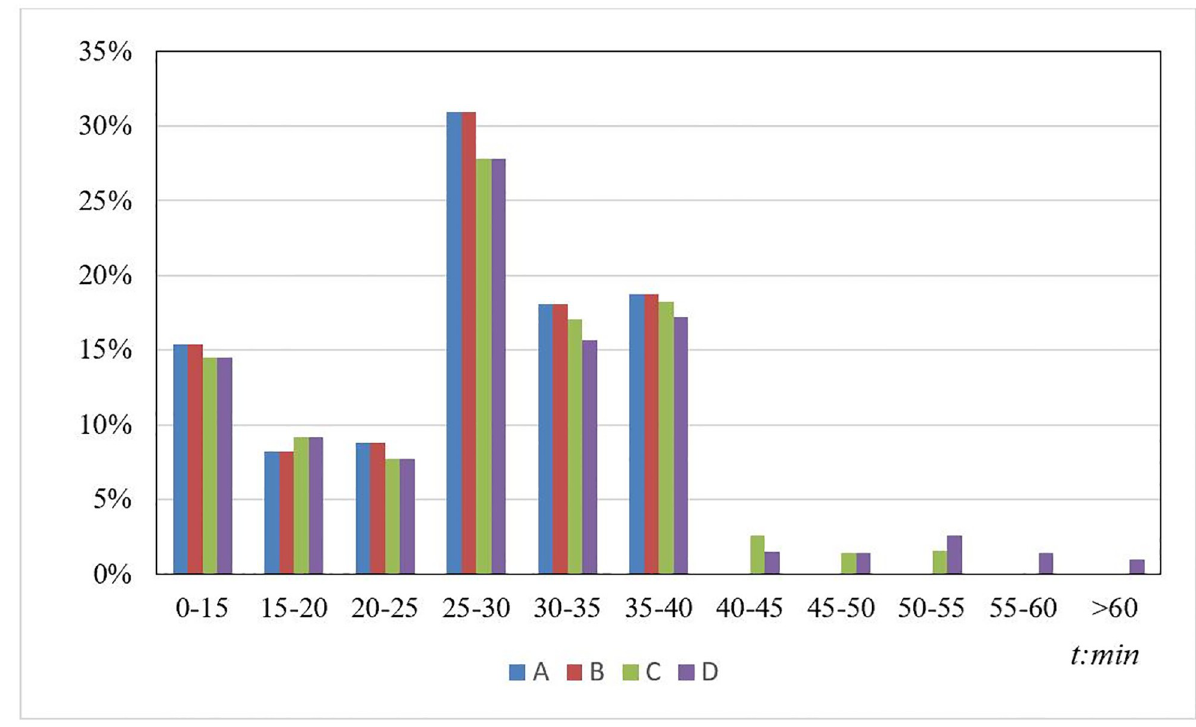
Fig 7. Travel delays for different resource